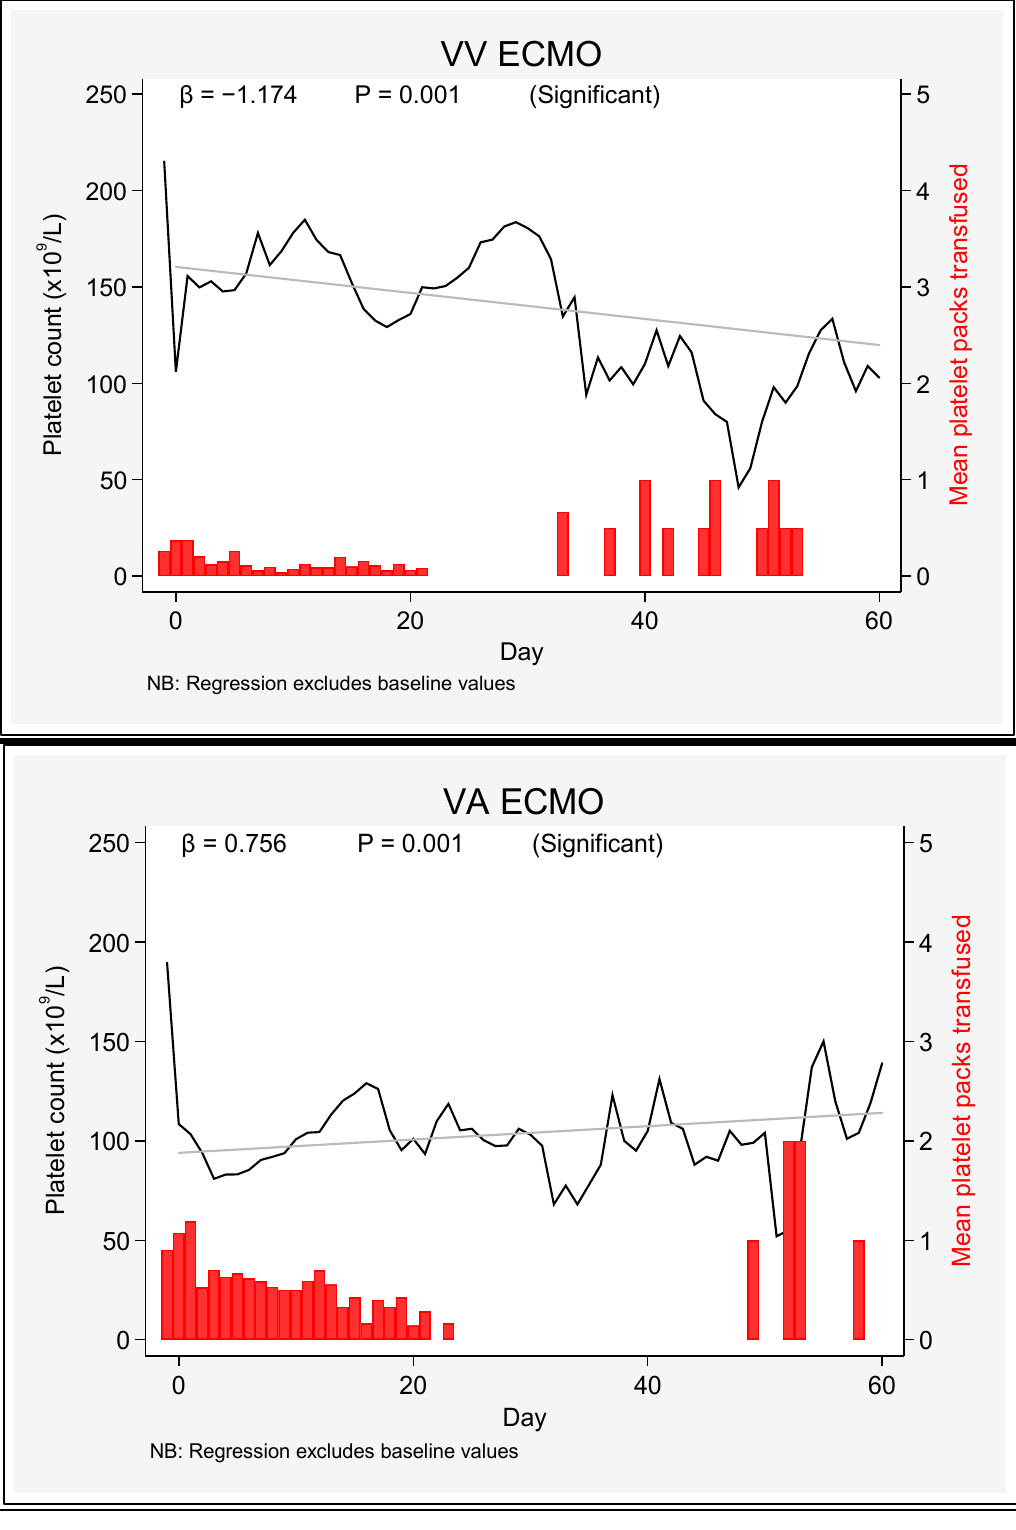
Figure 2. Platelet count and platelet transfusion requirements in VA and VV ECMO patients over 60 days. For fibrinogen and APTT, the ECMO mode was not a significant predictor ( p = 0.55 and p = 0.072, respectively) (Figure 3).